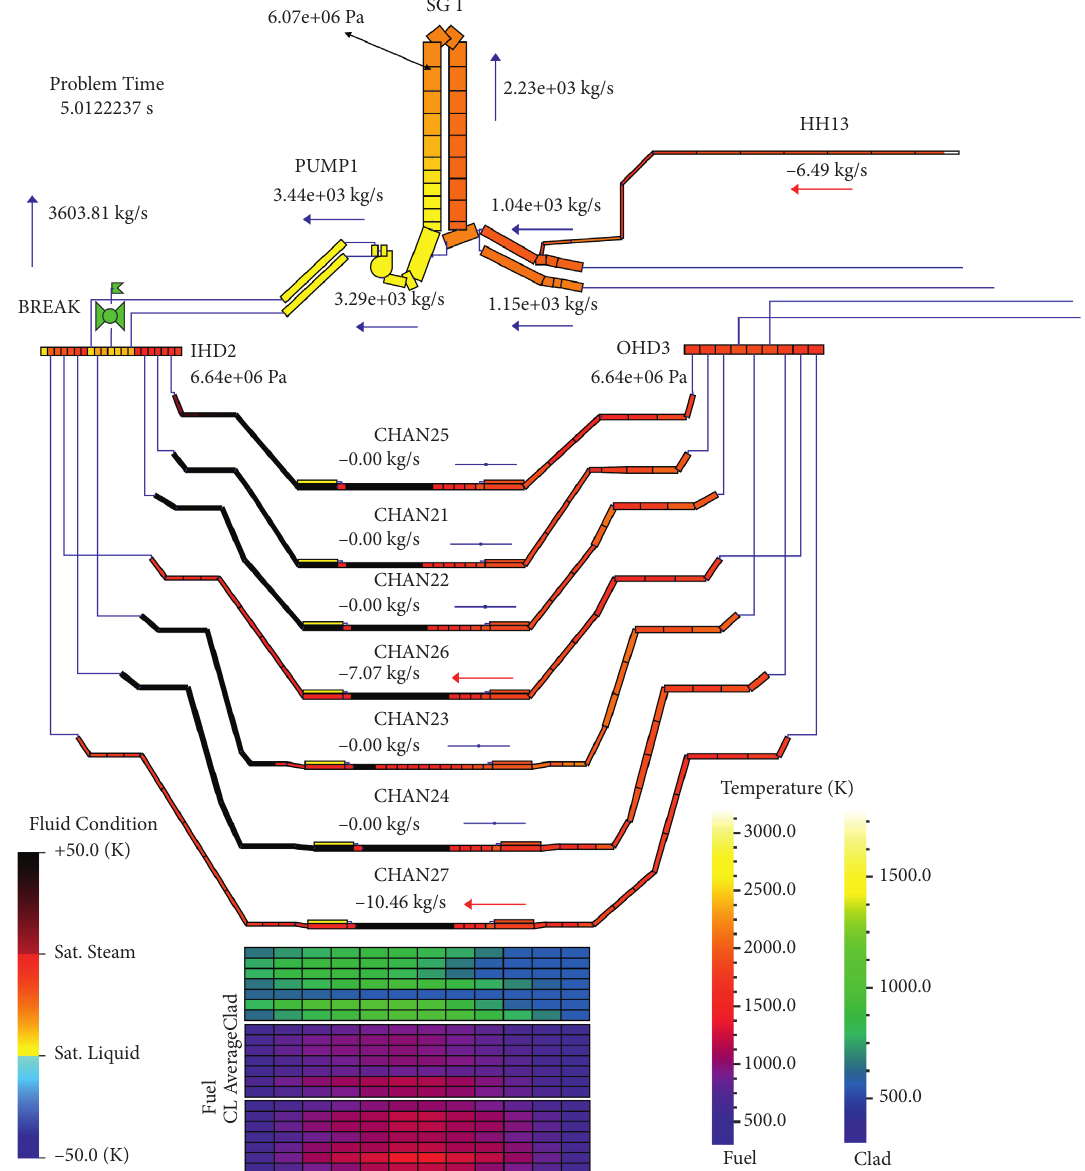
Figure 14: LOCA broken pass thermal-hydraulic conditions after 5.0